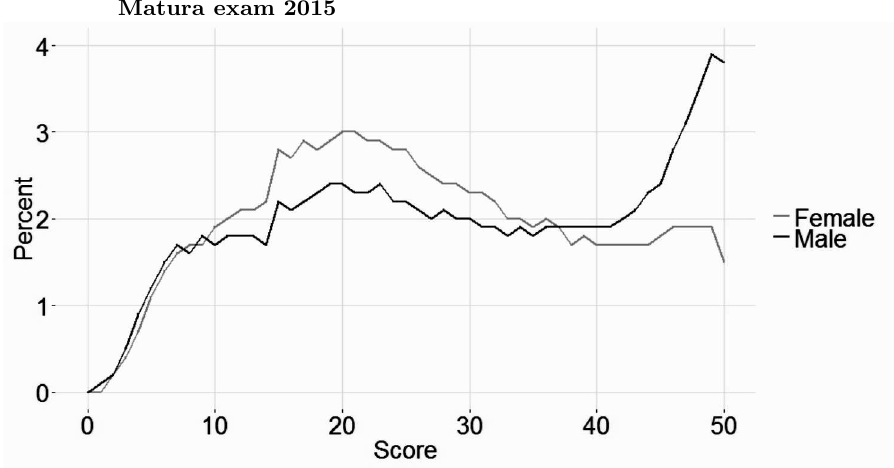
Figure 1. Percentage of males and females on given score level on basic Matura exam